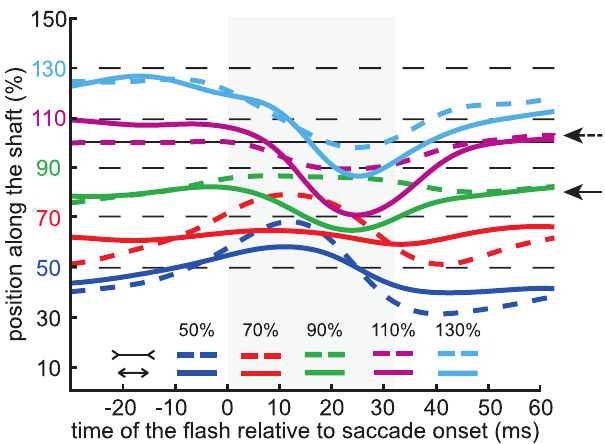
Figure 4. Averaged mislocalization curves for each flash location and figure configuration. The flash locations are indicated by dashed black lines. Each of the curves was first determined for each participant and shaft length, and then the curves were averaged. The instruction was to make saccades to the end of the shaft of the Mu¨ller- Lyer figure (solid black line at 100%). The horizontal arrows at the right side of the figure indicate the average saccade landing positions for the fins-out configuration (dashed arrow) and the fins-in configuration (solid arrow). The grey area shows the average saccade duration.